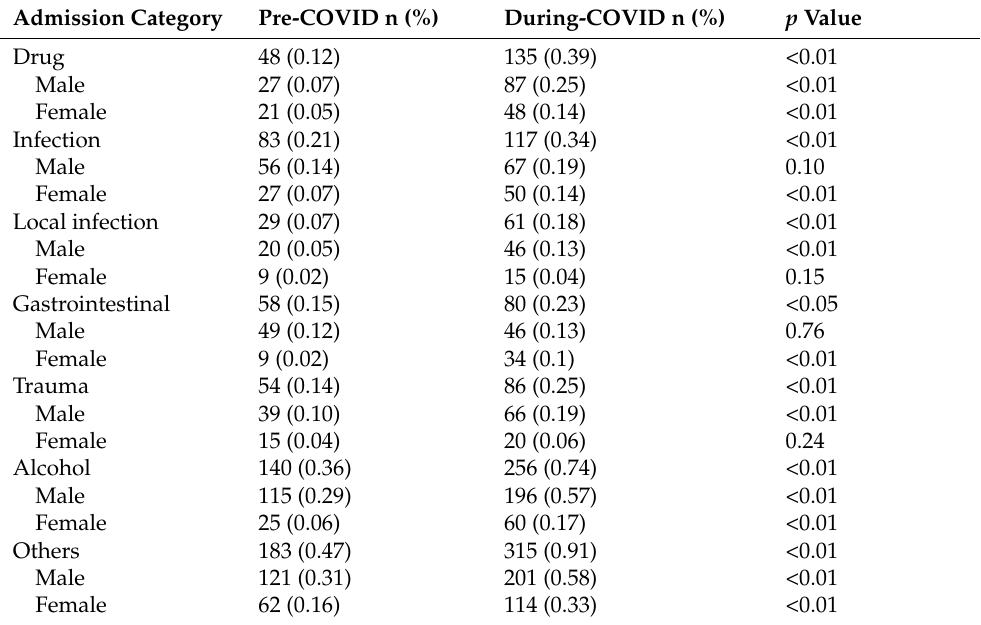
Table 3. ED admission rates for non-Indigenous patients with SUD before and during the COVID-19 pandemic (the denominator is the total number of